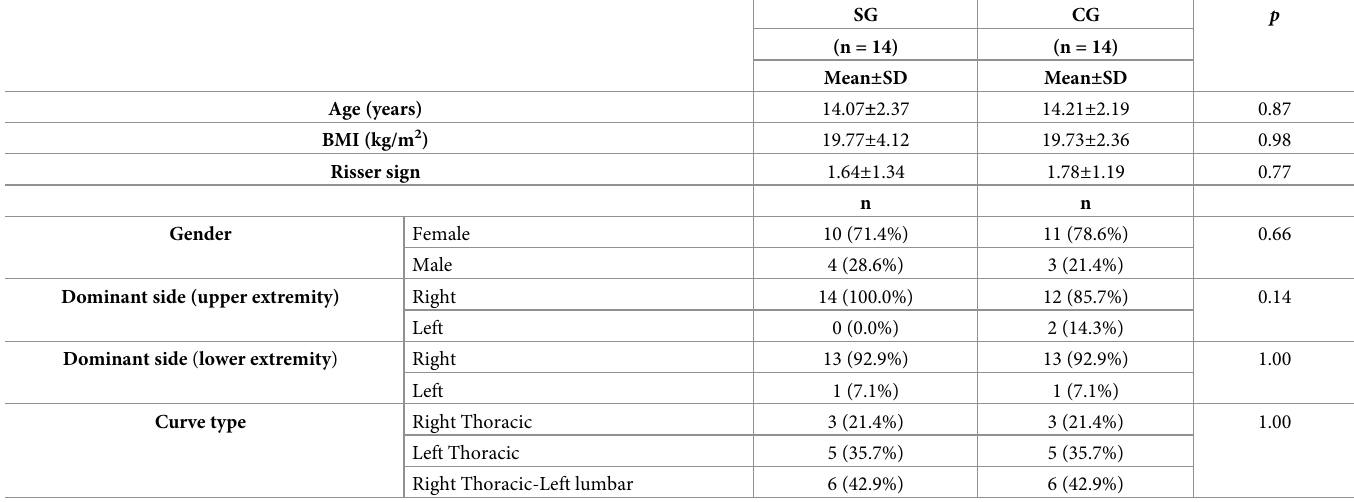
Seventy-six scoliosis patients were admitted to the department, and 28 (21 females, 7 males) satisfied the inclusion criteria. The patient distributions were n = 14 for the SG and n = 14 for the CG after randomization. The study was completed with 100% attendance compliance. The flow chart of the study is shown in Fig 1. Baseline clinical and demographic characteristics of the patients are shown in Table 1. There was no significant difference between the two groups in terms of age, gender, body mass index, Risser sign, curve type, or dominant sides (p > 0.05). Table 1. Baseline clinical and demographic characteristics of